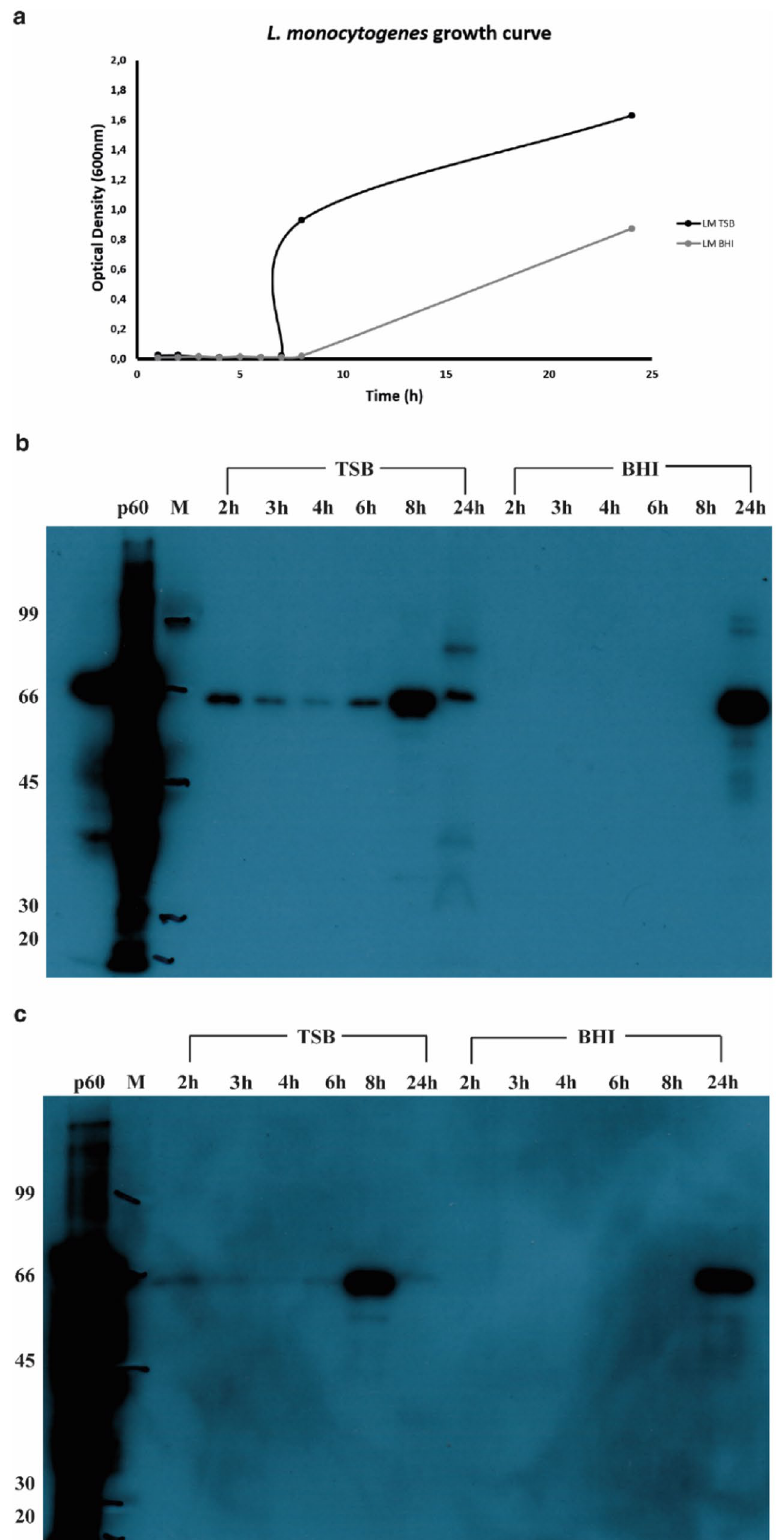
Figure 2. Bacterial growth curve and Western-blot analysis of the p60 production. (a) The kinetic bacterial growth curves—black colour—the results obtained with the TSB medium; grey colour—the results obtained with the BHI medium and (b) Western-blot with the LM pAb and (c) Western-blot with the LM mAb. p60 is the recombinant protein; M: molecular size marker; 2 h, 3 h, 4 h, 6 h, 8 h and 24 h was the sample collected during the growth grouped by culture medium used (TSB and